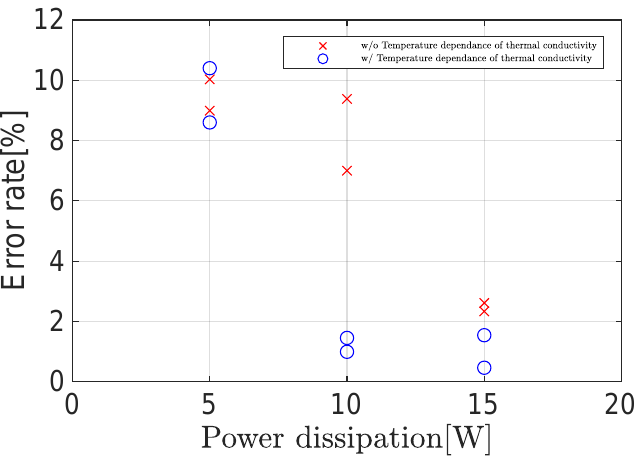
Figure 17. Error rate (w/ operator